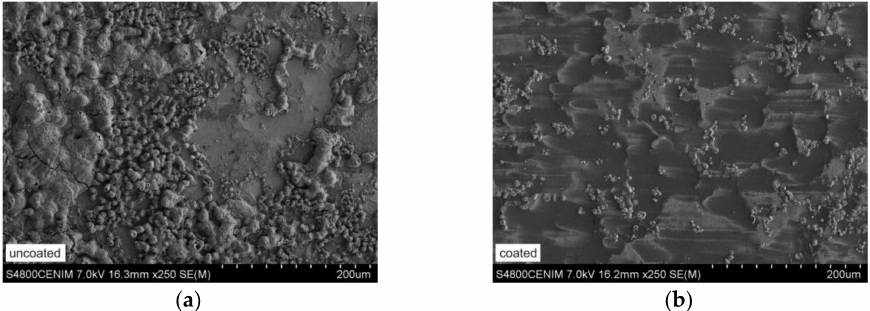
Figure 10. FESEM image of a steel substrate after the weathering test in the climatic chamber: